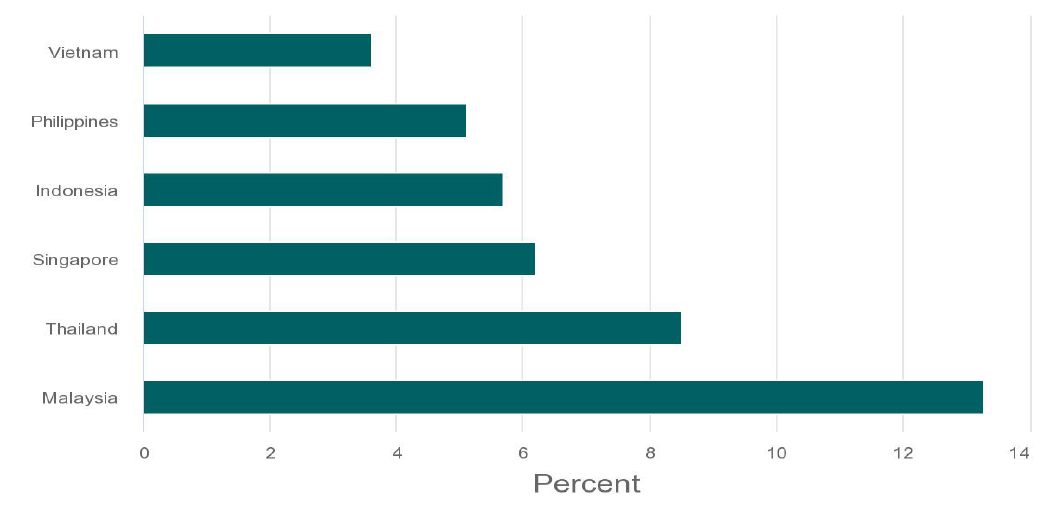
Figure 9: Rate of Obese Adults Per Population in Southeast Asia, 2014 Source: Jamrisko